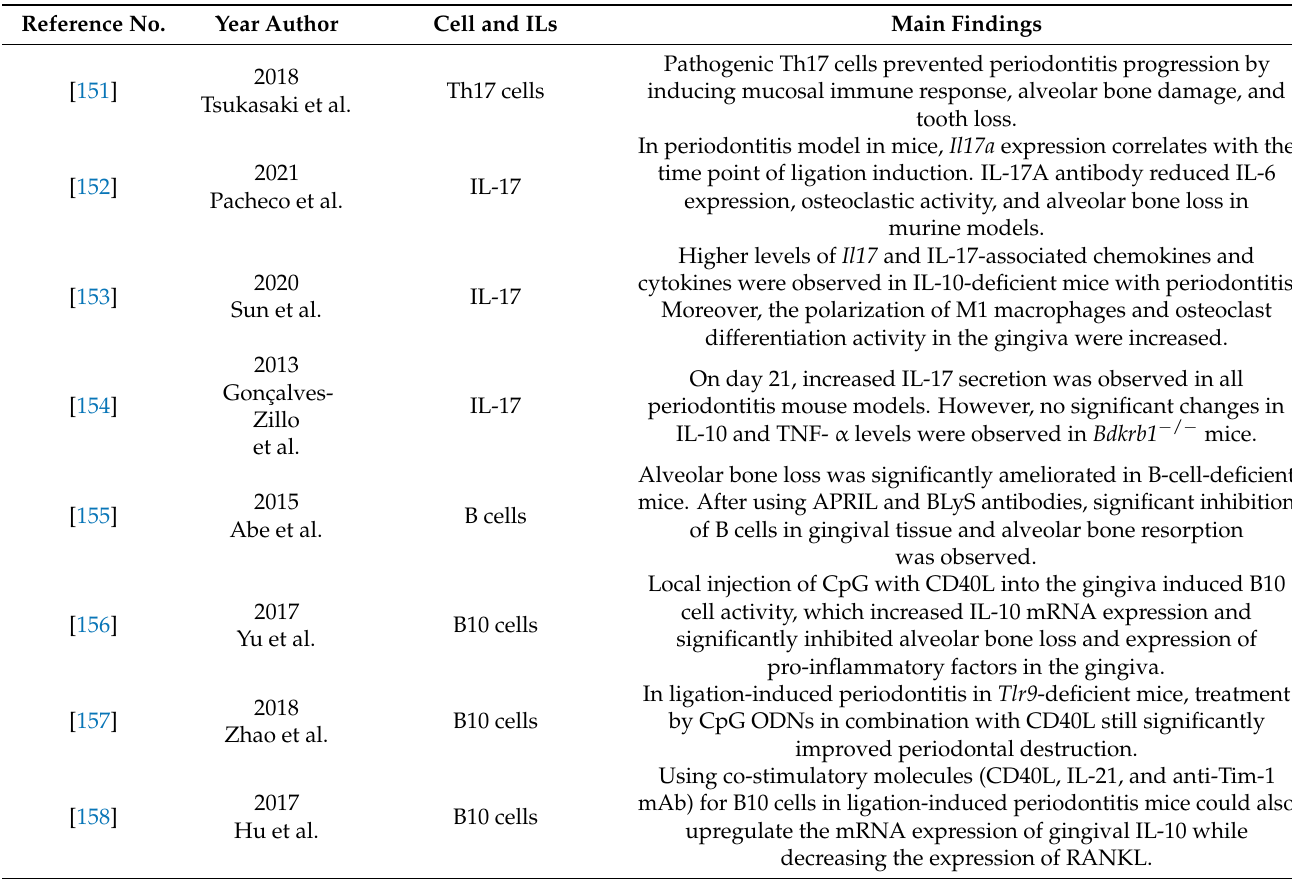
Table 5. Summary of acquired immunity in ligature-induced periodontitis model in mice. Reference No.